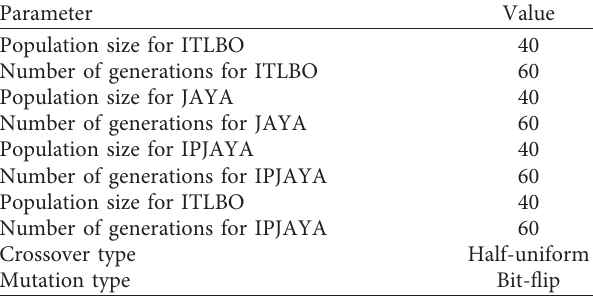
Table 10: Parameters used in this study;